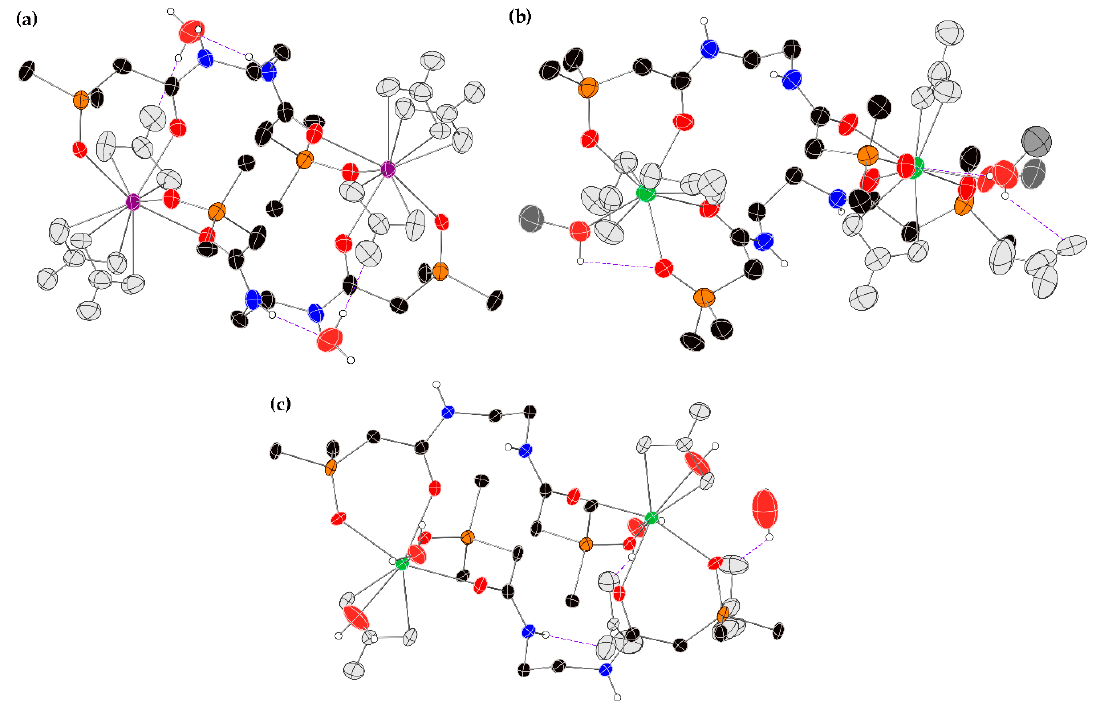
Figure 4. X-ray crystal structures of the 2:2 complexes between phenyl-substituted ligand 2 and Sm(NO 3 ) 3 and Tb(NO 3 ) 3 using standard CPK colors (Sm 3+ : purple, Tb 3+ : green). The atoms of the nitrate groups are colored grey in order to make it easier to visualize the ligand and metal coordinationgeometry. Thermalellipsoidsaredrawnatthe40%probabilitylevel, andhydrogenbonding interactions are depicted with purple, dashed lines. ( a ) The [Sm(NO 3 ) 3 ( 2 )(H 2 O) 2 ] 2 complex; ( b ) the 2:2 [Tb(NO 3 ) 3 ( 2 )] 2 • H 2 O complex; ( c ) the major component of the 2:2 [Tb(NO 3 ) 3 ( 2 )(MeOH)] 2